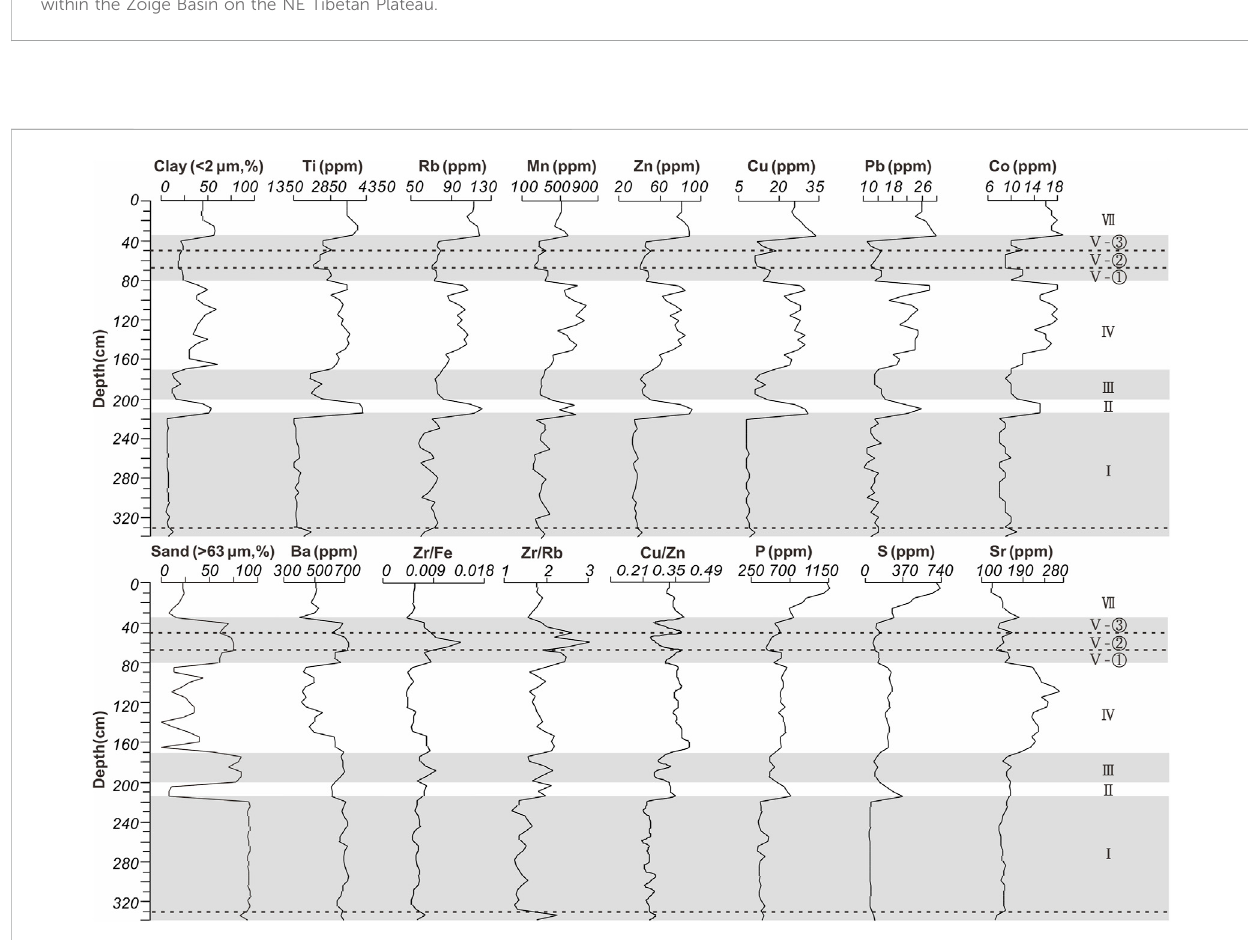
FIGURE 5 Grain size distribution and trace element Ti, Rb, Mn, Zn, Cu, Pb, Co, Ba, P, S, Sr concentrations and element ratios of Zr/Fe, Zr/Rb, and Cu/Zn of the paleo-oxbow lake fi ll at NYQ-B site within the Zoige Basin on the NE Tibetan